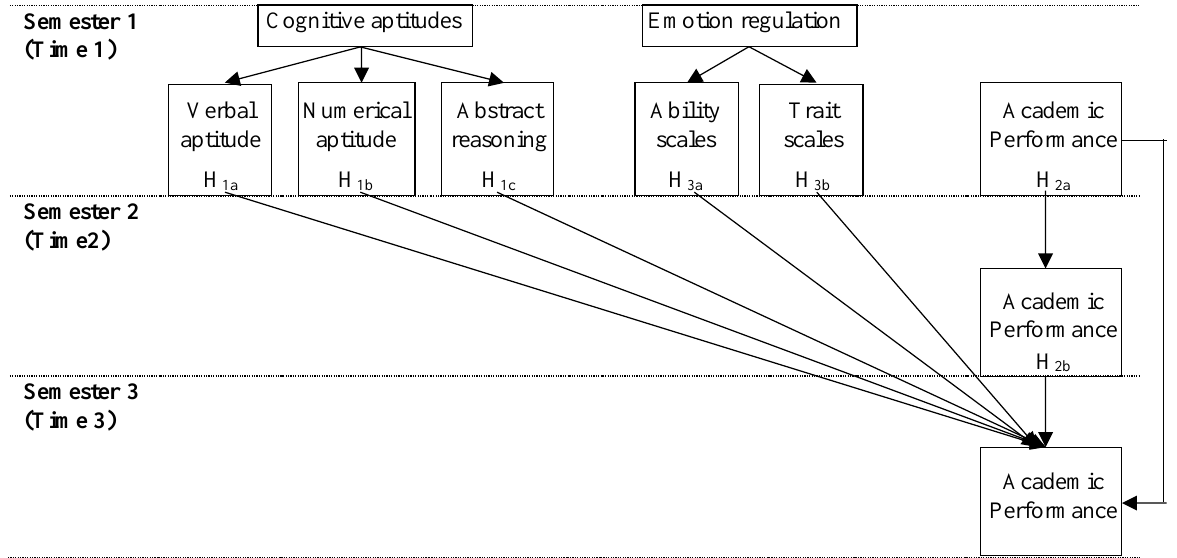
Figure 1. Variables under study and hypothesised model